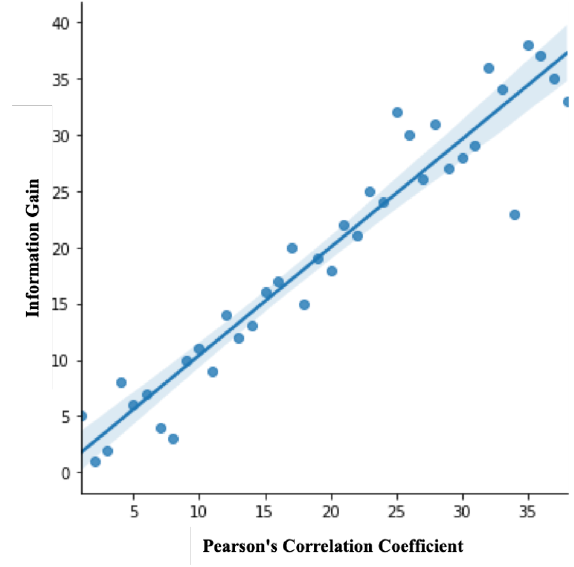
Figure 7. Spearman’s Rank Correlation